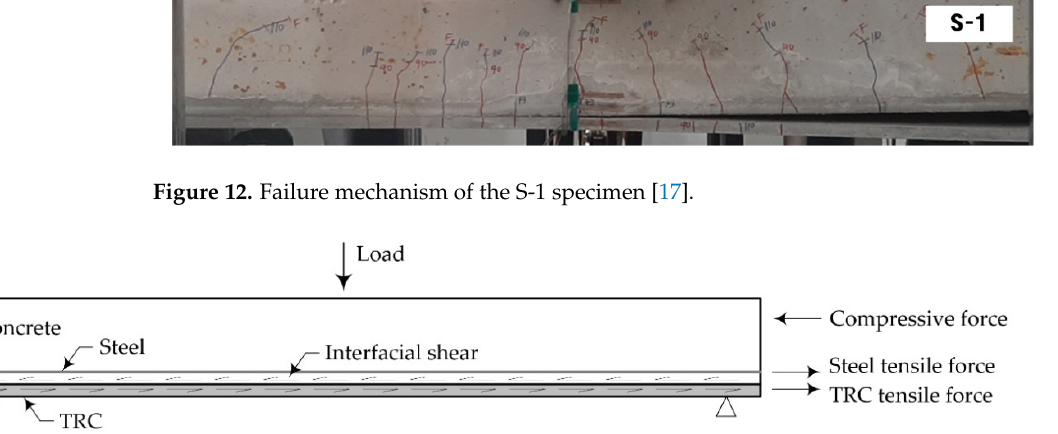
Figure 11. Comparison of load-displacement curves of TRC strengthened slabs. Figure 12. Failure mechanism of the S ‐ 1 specimen [17].